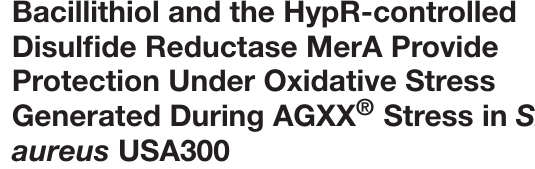
Frontiers in Microbiology |